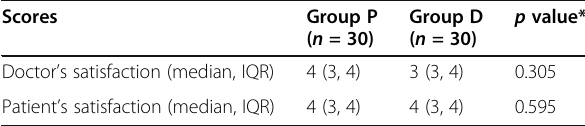
Table 5 Comparison of patient ’ s and endoscopist